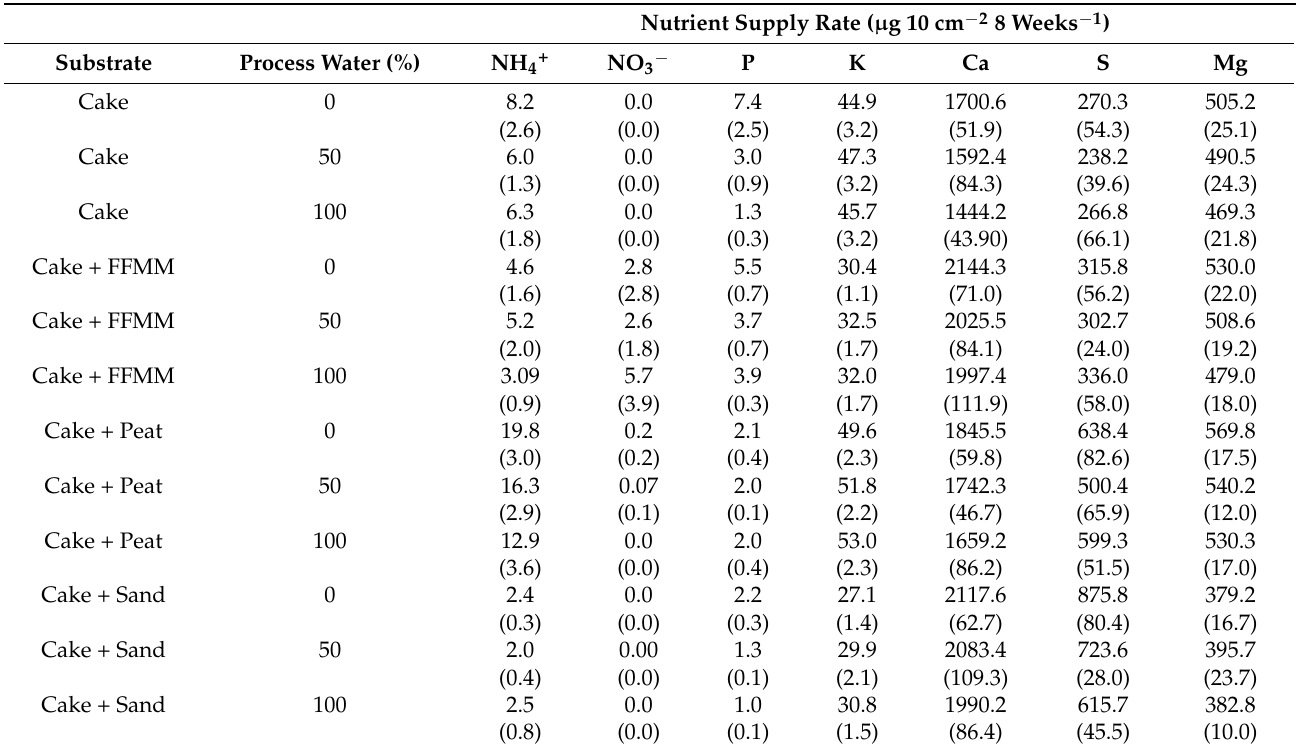
Table 3. Mean values (associated standard errors) of supply rates of nutrients over an 8-week period for tailings cake and cake-amendments under three watering